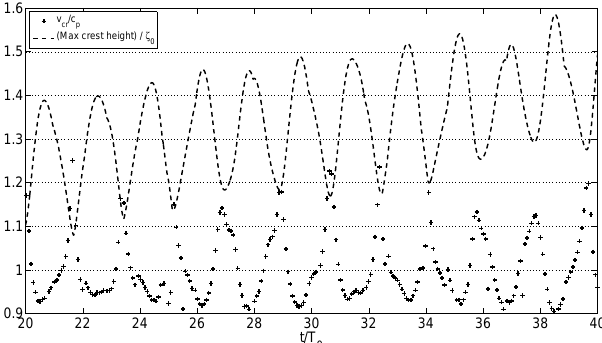
Figure 6. The computed variation with time of the normalized max- imum crest elevation relative to the background wave amplitude ζ 0 and the velocity of the highest crest propagation ( v cr ) relative to the phase velocity c p = 1 . 248ms − 1